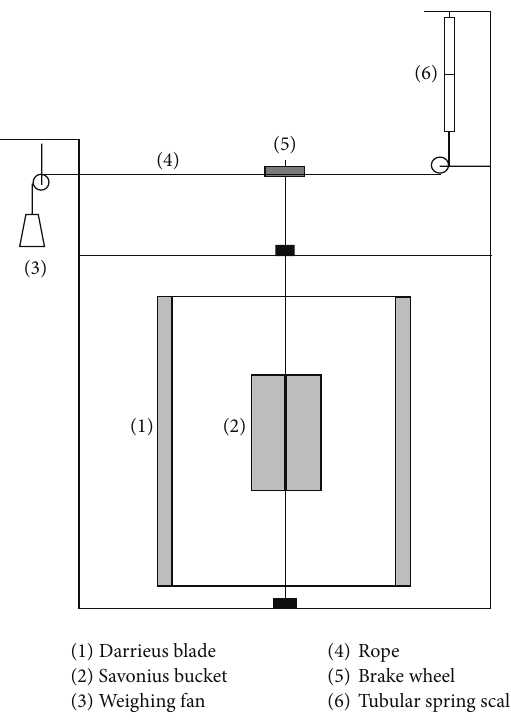
Figure 3: Schematic diagram of the test setup for the Darrieus- Savonius turbine.